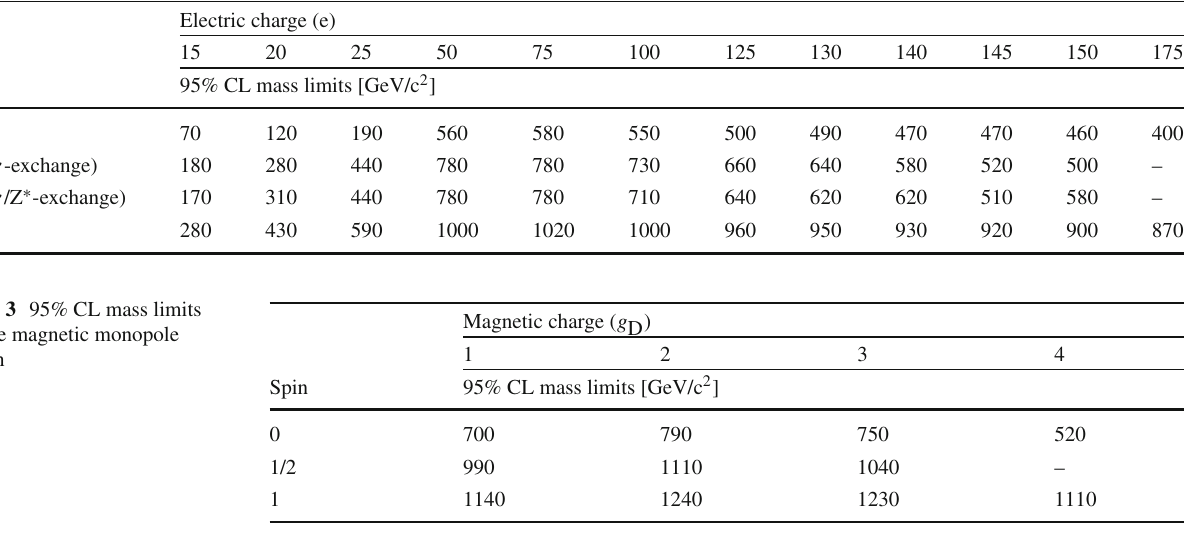
Fig. 20 95% C.L. upper limits to the cross-section using as a measure a DY model for spin of 0 , 1 / 2 and 1 magnetic monopole production assuming a β − independent monopole coupling. The solid lines denote the DY cross-sections for each case considered Table 2 95% CL mass limits for the HECO search